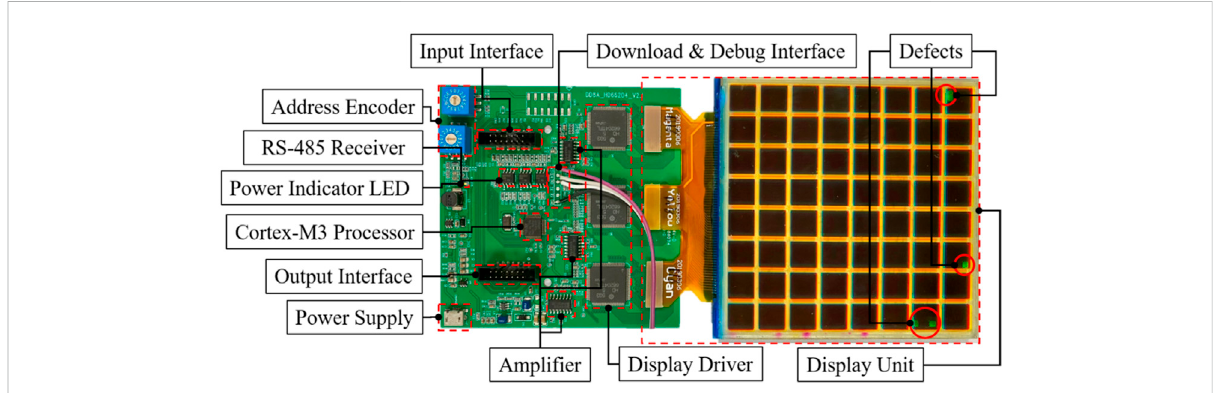
FIGURE 6 Thearchitectureanddetailsoftheexperimentalplatform. Theexperimentalplatformconsistedofadrivingboardandadisplayunit.Thedriving boardprovidedinputandoutputinterfacesforDMXsignalsfortheexpansionofthedisplaymodule.Itwasalsoresponsibleforcontrollingtheoutput voltageappliedtopixelelectrodesbasedonthereceivedimagedata.Thedisplayunithadathree-layercolorstructure.Eachpanelofthedisplayunit was driven by a graphic driver chip.